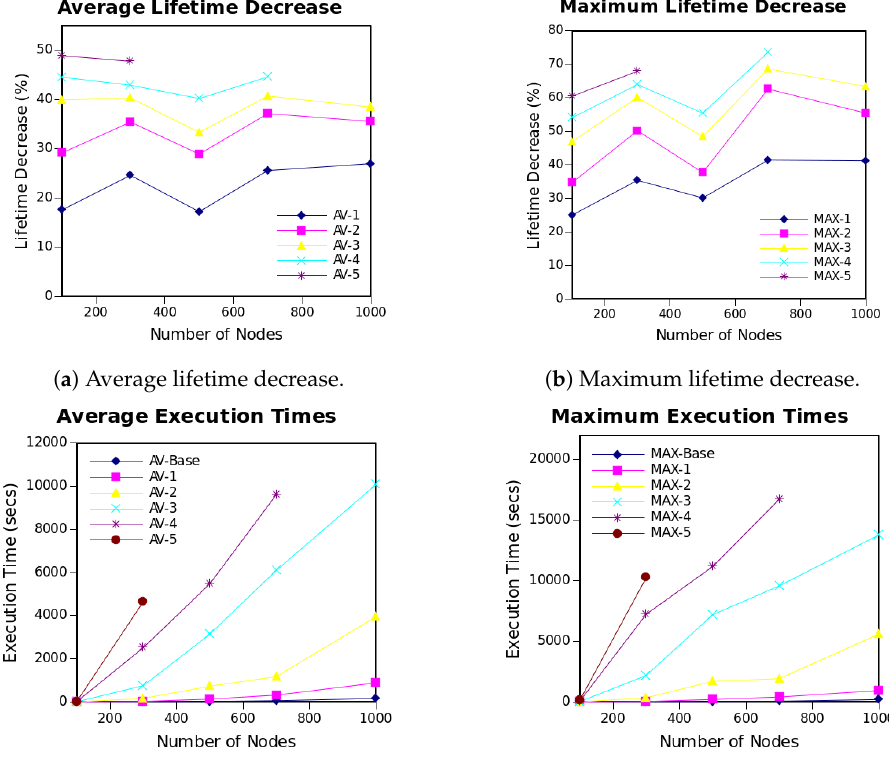
Figure 6. Average and maximum lifetime decrease values and execution times for networks with nodes distributed according to area specified in Table